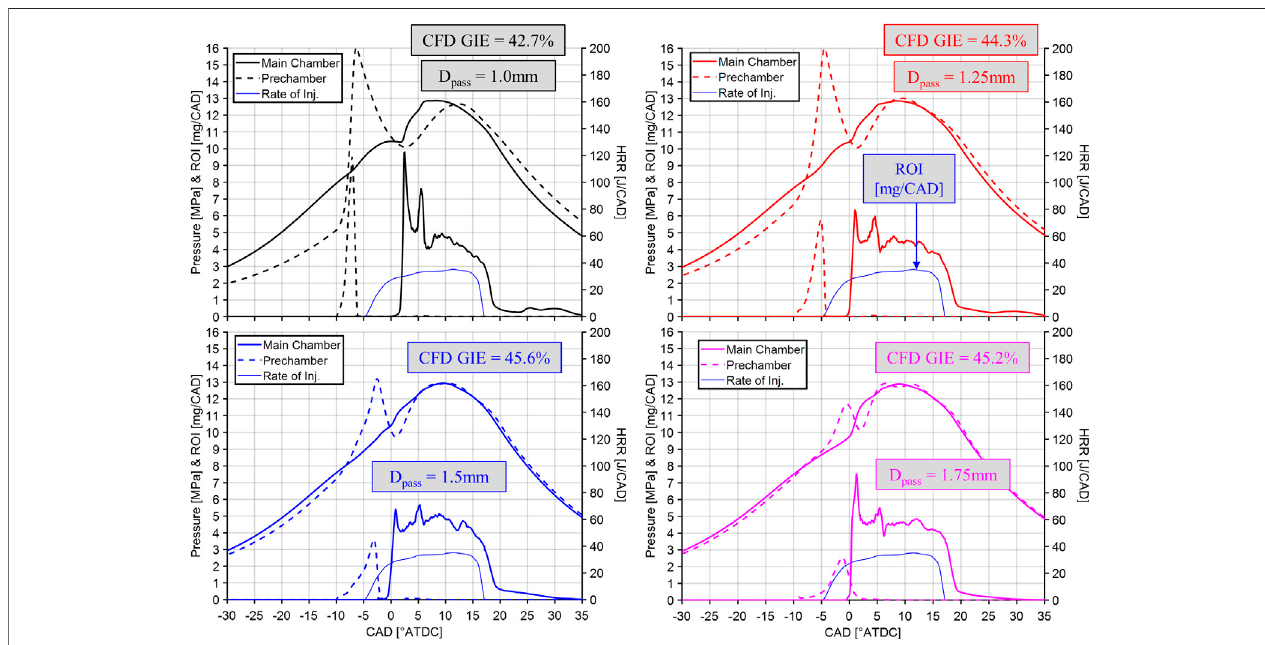
FIGURE 8 | CFD predicted pressure and heat release rate for PC-MCC operation over a parametric sweep of passageway diameter. Operation is with pure methanol fuel.